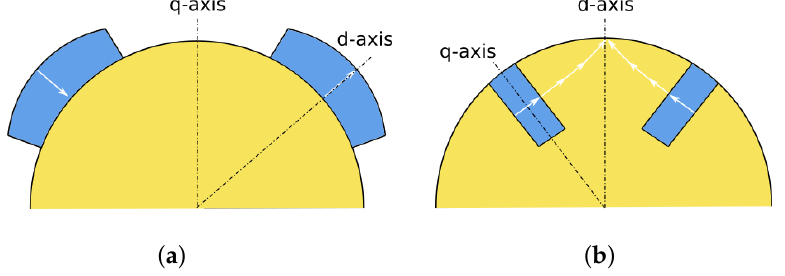
Figure 7. ( a ) Surface-mounted, ( b ) flux-concentrating PMs. Other configurations use an axially magnetized PM ring between two iron cores (Figure 8b) [67,85,86,116,117] or are directly in contact with the air gap, thus eliminating the intermediate iron cores [118,119]. If that is the case, PM segmentation must be considered to prevent high eddy currents in a solid PM ring [85].